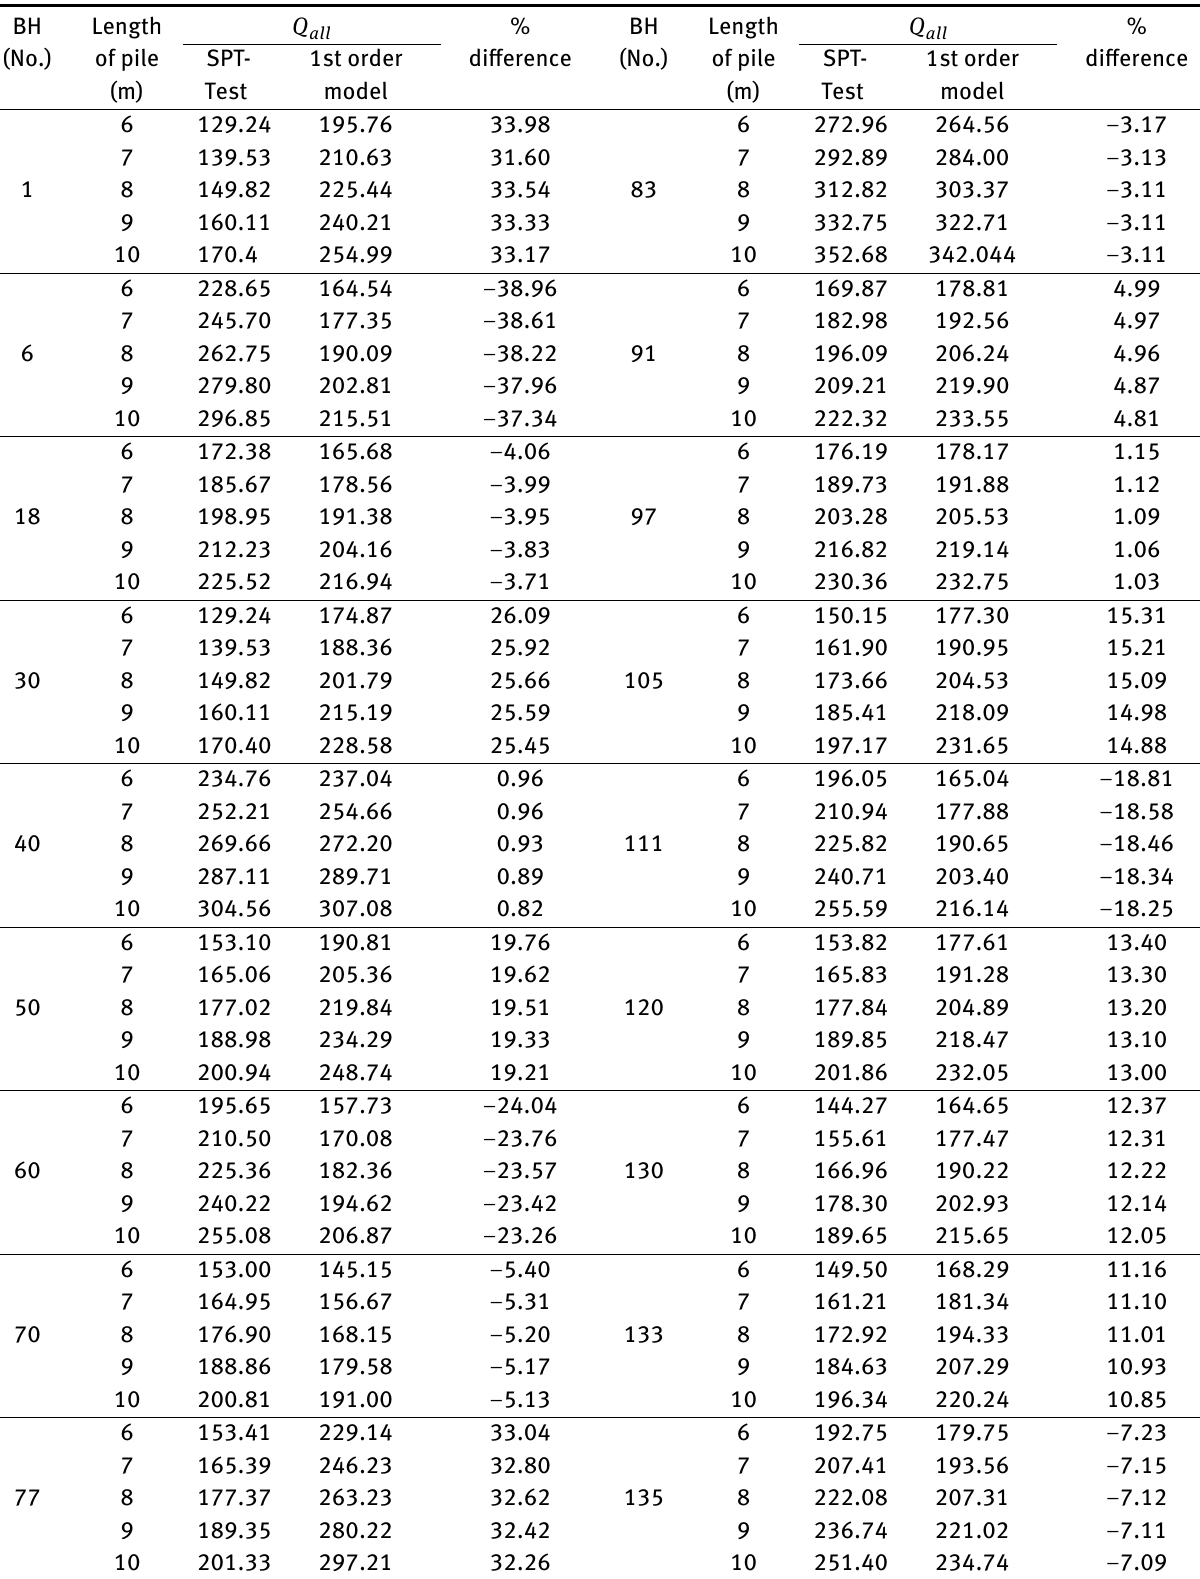
Table 6: Comparison of allowable bearing capacity of driven piles predicated from 1st order polynomial and those calculated from SPTs BH